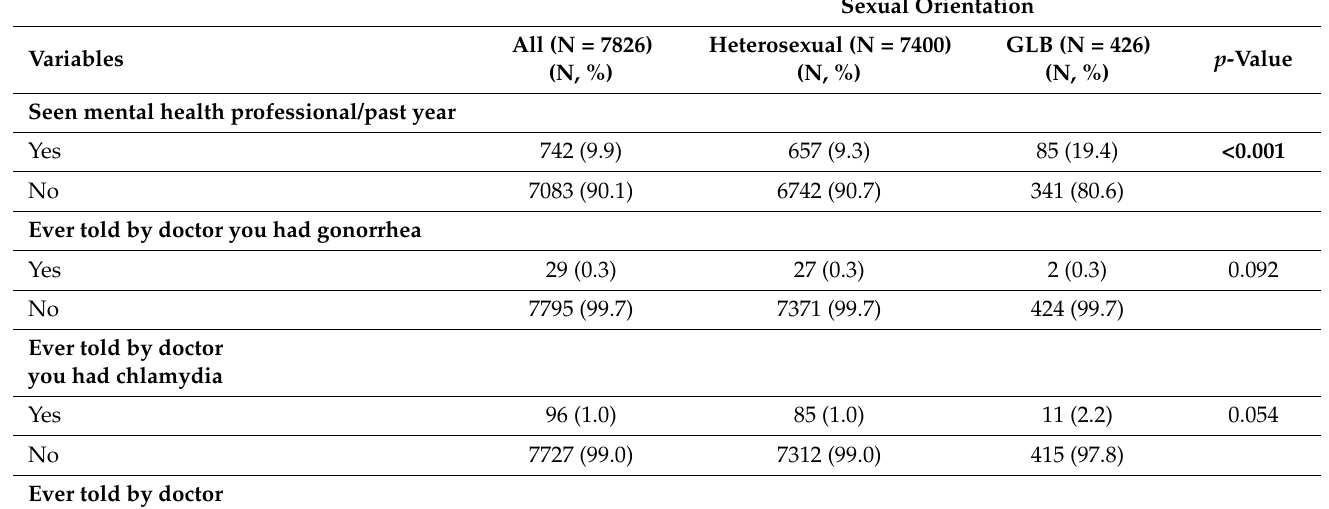
Table 2. Behavior characteristics of sexual minorities compared to heterosexuals (NHANES 2011–2016). Sexual